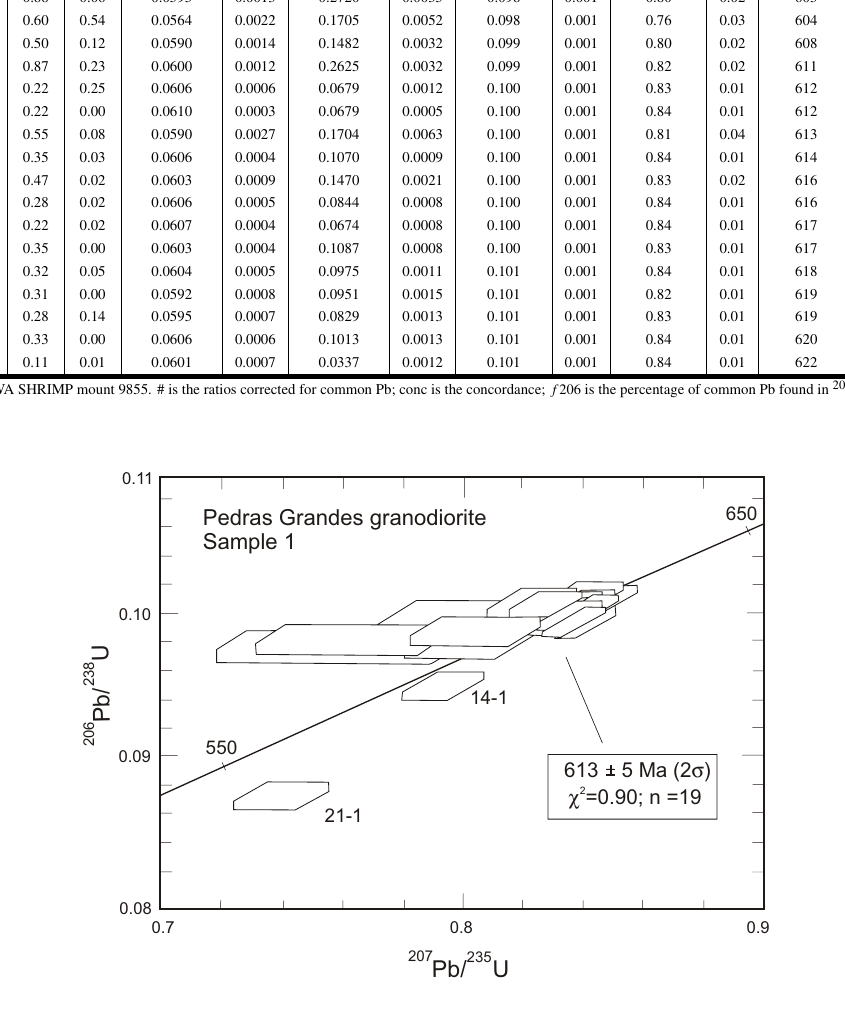
Fig. 3 – Concordia diagram for SHRIMP U-Pb data of 19 zircon grains (21 analy- ses). Two analyses not included in age calculation are identified (14-1 and